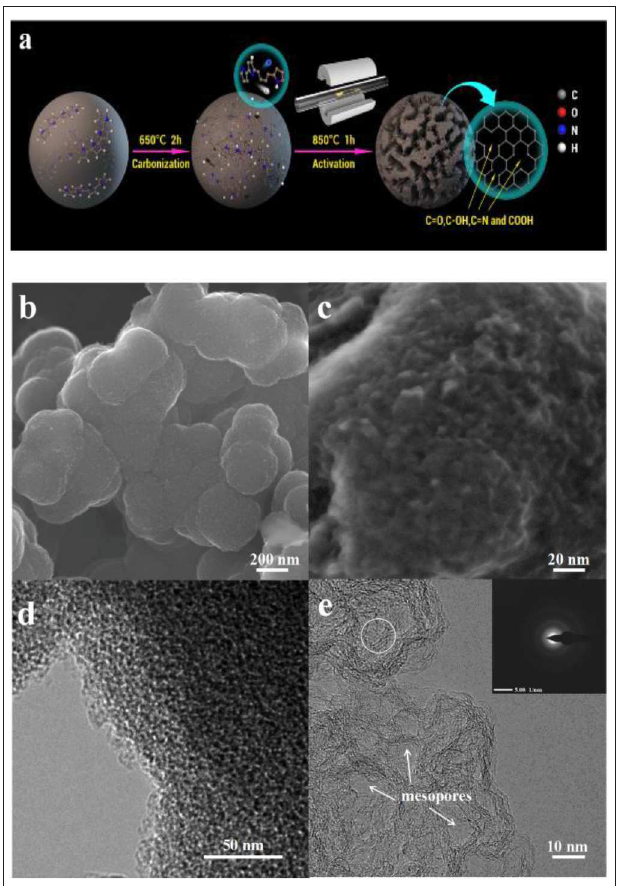
FIGURE 1 | (a) Schematic illustration of the synthesis of polypyrrole (Ppy)-derived porous carbon materials. (b,c) Scanning electron microscopy (SEM) image of PPy activated at 850 ◦ C (APPy-850). (d,e) Transmission electron microscopy (TEM) image of